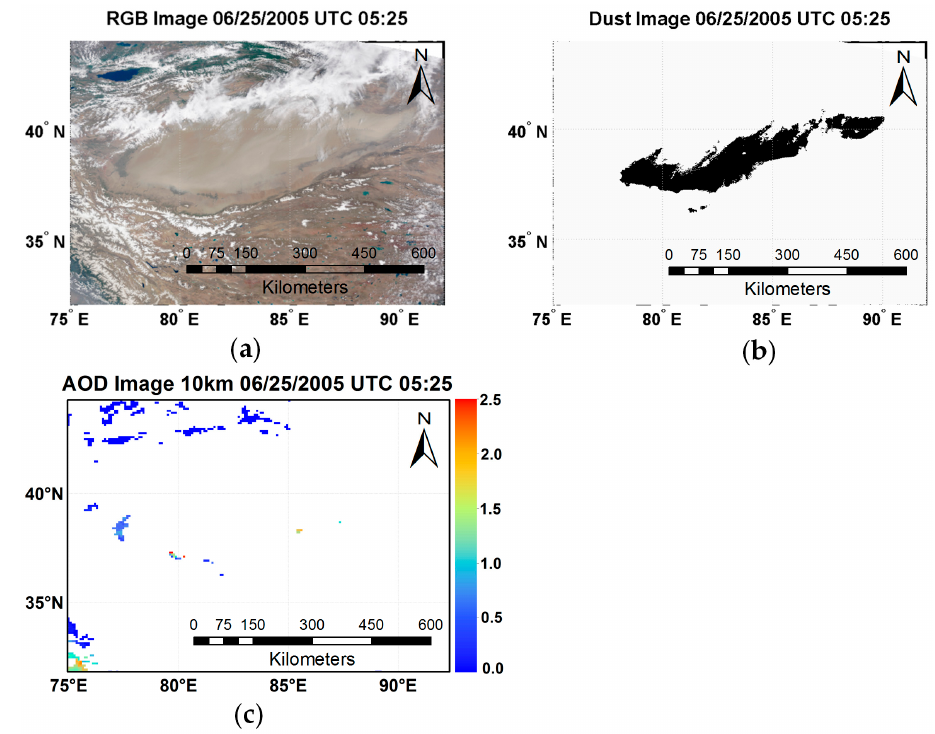
Figure 6. Dust storm over Taklimakan Desert on 25 June 2005. ( a ) MODIS true color image; ( b ) dust image; and ( c ) Aerosol Optical Depth (AOD) image.